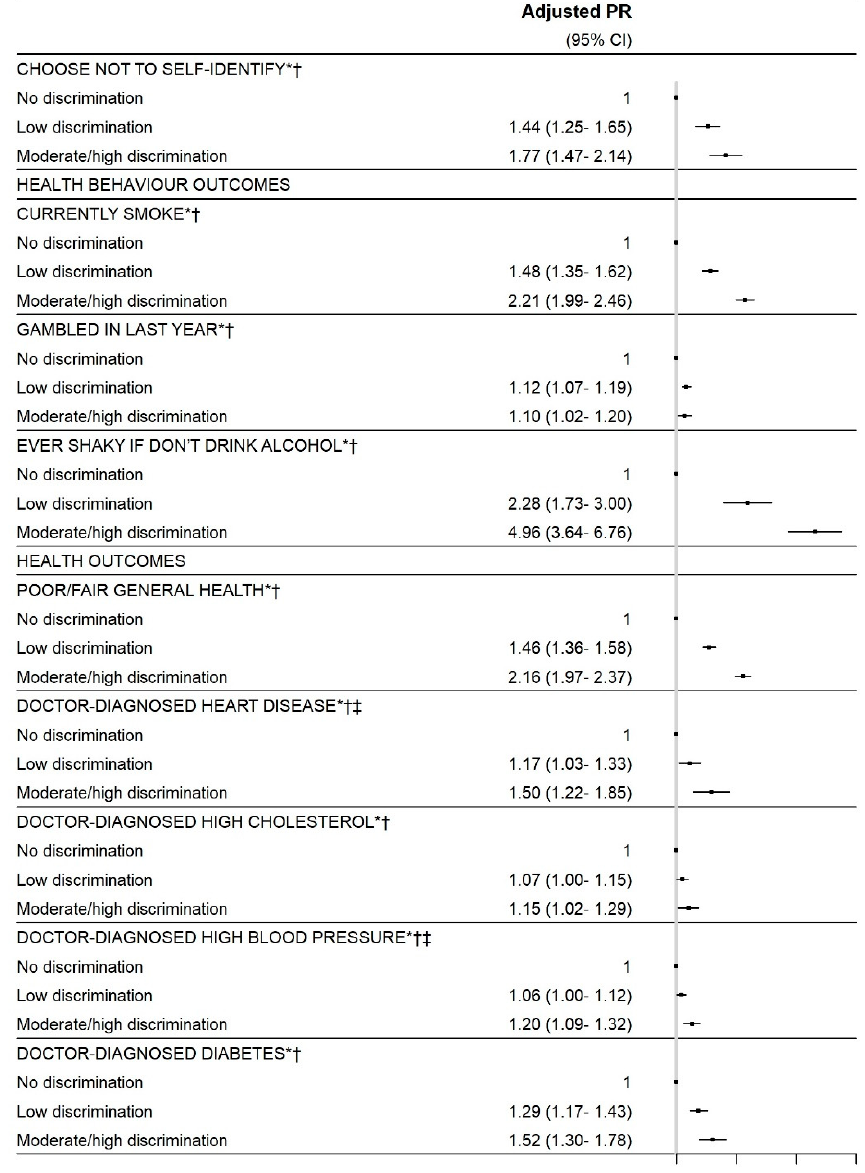
Figure 1. Relationship between experiences of everyday discrimination and wellbeing outcomes ( n = up to 8100). The adjusted models are adjusted for age group, gender (male or female), and remoteness. Due to small numbers, participants identifying as another gender are excluded from all regression analyses as the fully-adjusted models are adjusted for gender. All models exclude participants missing the outcome of interest.* Indicates that the overall discrimination score variable is significant in the adjusted model, with the p -value for the Wald test <0.05. † Indicates that the trend is significant in the adjusted model (when the discrimination score is included as a continuous variable, set to the mean total score for each discrimination category), with the p -value for trend <0.05. ‡ Indicates that the adjusted model for the outcome (heart disease, blood pressure) employs a collapsed age categorisation (16–65 years, ≥ 66 years) due to small cells. See Table S2 for numbers of participants, unadjusted PR, and crude outcome prevalences by exposure category.